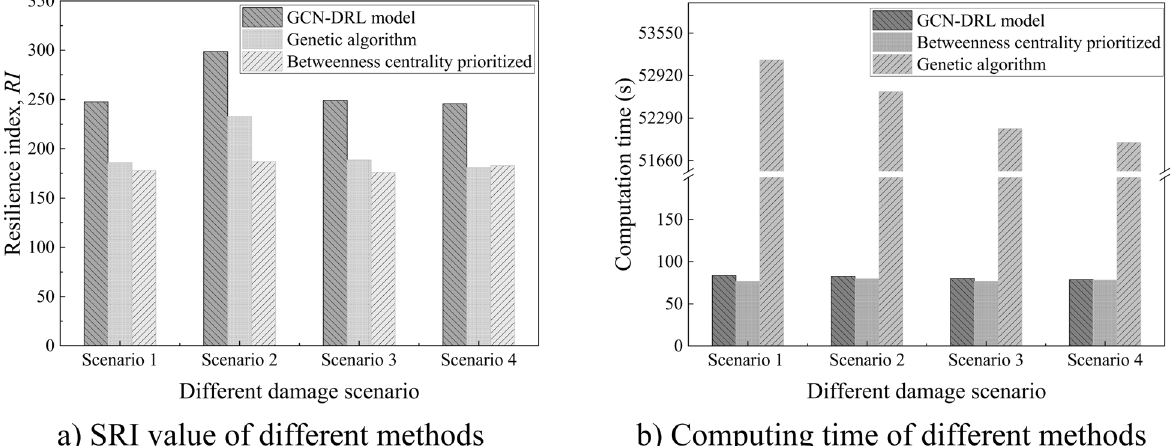
Fig. 12 Comparison of the system recovery based on repair decisions by different methods a the final SRI; b the computational